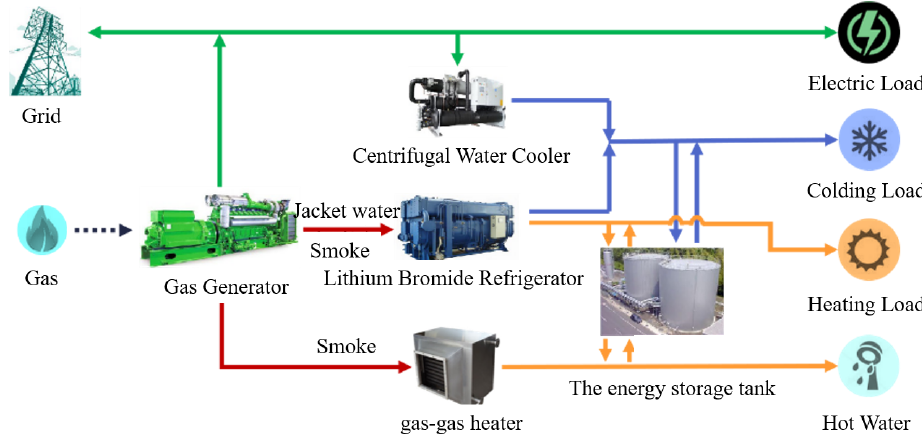
Figure 1. System block